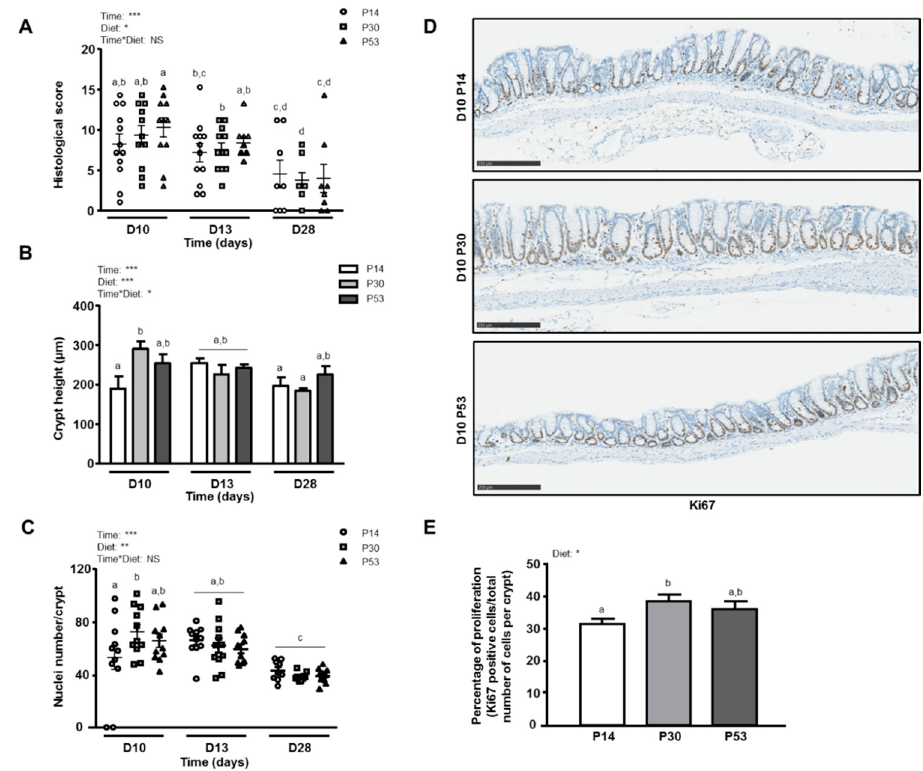
Figure 3. Effects of dietary protein intake on colon histomorphology after 3 (D10), 6 (D13) or 21 days (D28) of dietary intervention with P14, P30 or P53 diet. ( A ): Histological score. ( B ): Colon crypt length. ( C ): Cell numeration. ( D ). Representative illustrations of longitudinal colonic sections immunostained with an anti-Ki67 antibody. ( E ): Percentage of proliferation (Ki67-positive cells/total number of cells per crypt) at day 10 . Values are means ± SEM ( n = 9–12). Means that are significantly different ( p < 0.05) according to the post-hoc test have different letters (a or b or c or d). *: p < 0.05; **: p < 0.01; ***: p < 0.001; NS: non-significant difference.